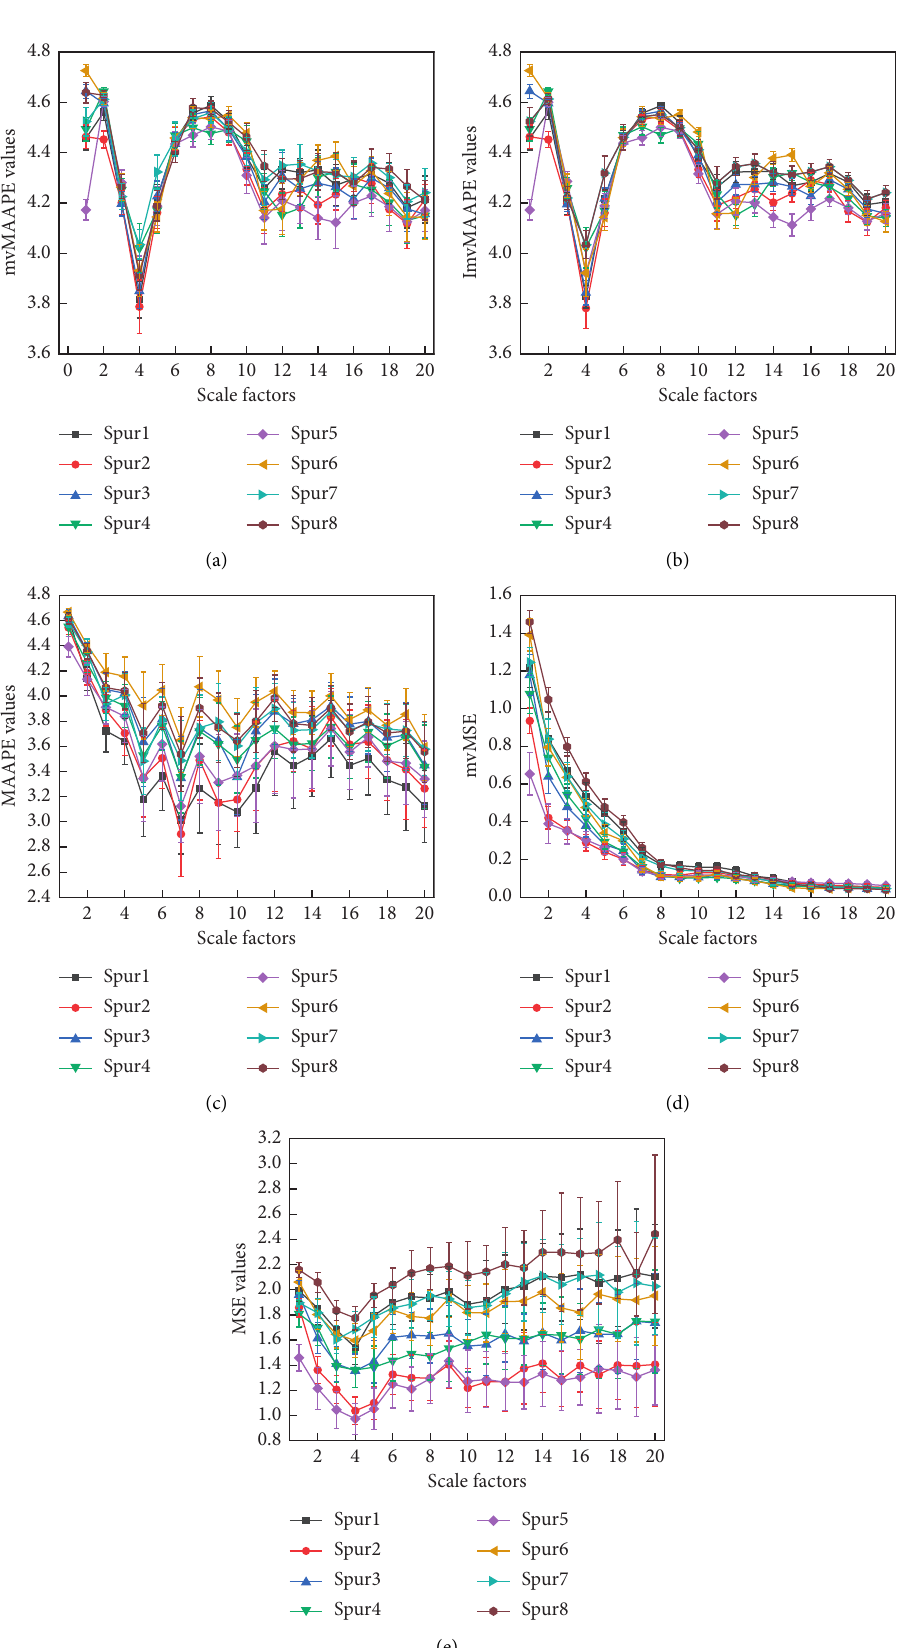
Figure 17: Gearbox entropy analysis diagram of five multiscale analysis methods: ImvMAAPE (a), mvMAAPE (b), MAAPE (c), mvMSE (d), and MSE